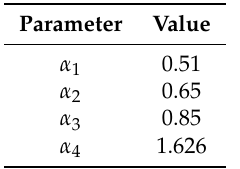
Table 3. Parameters used for the